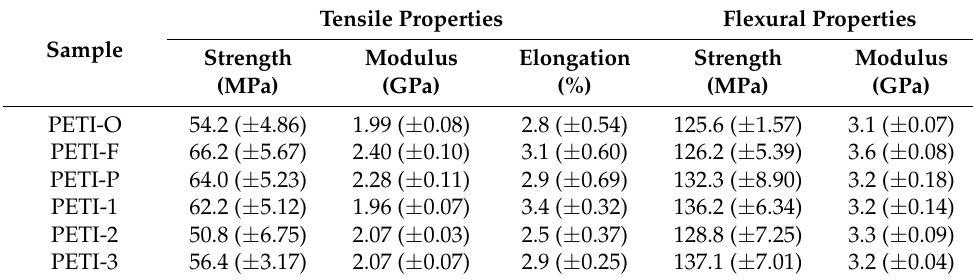
Table 8. Mechanical properties of the cured resins.